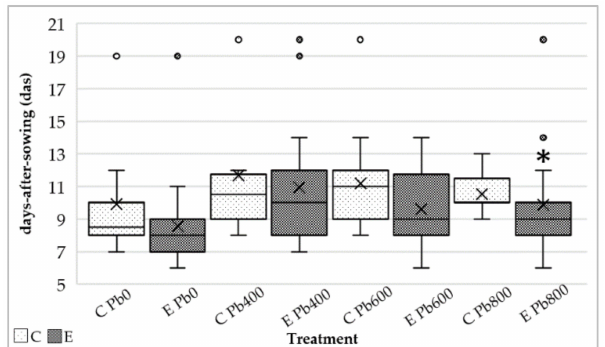
Figure 3. Germination time (here indicated as days-after-sowing, das ) of Festuca arundinacea seeds. Endophytic treatment is indicated by the letter E and control by the letter C at increasing concentration of lead in the soil. The significant statistical di ff erence ( p < 0.05) between endophytic and control set is marked with a